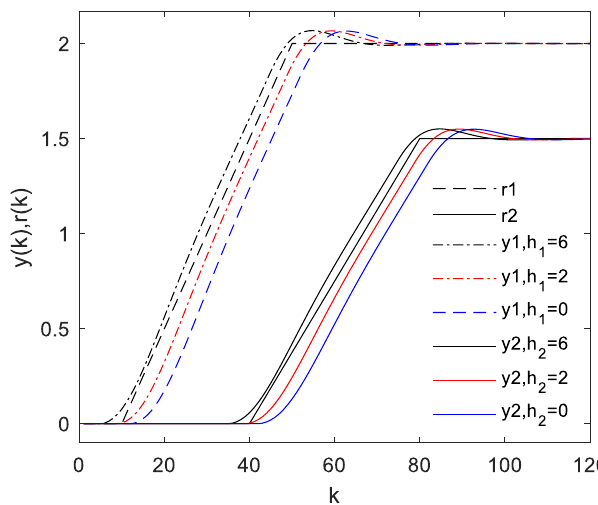
Figure 9. The output of System (1) with different R M .